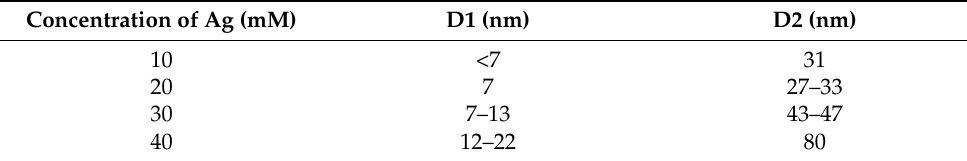
Table 1. Average diameters of AgNPs (D1 and D2) at different